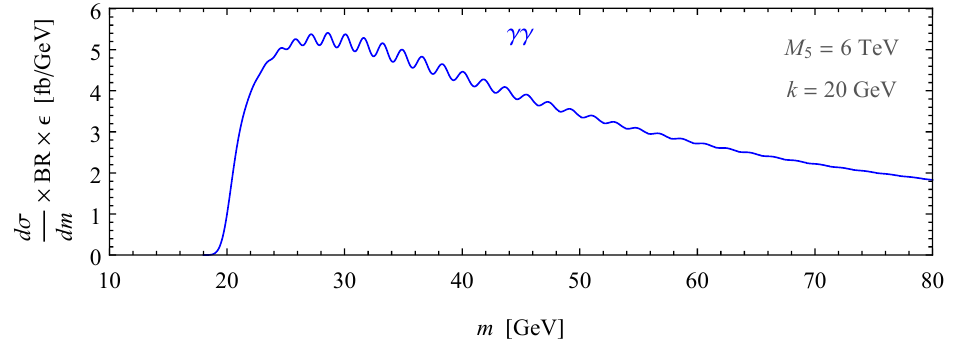
Figure 19 . Signal in the diphoton spectrum at the 13 TeV LHC for M 5 = 6 TeV and k = 20 GeV, after accounting for the experimental resolution according to eq.